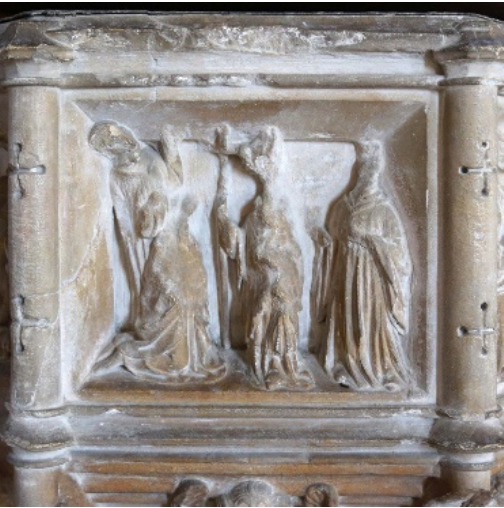
Figure 18. Ordination. Source: Bob Mitchell.